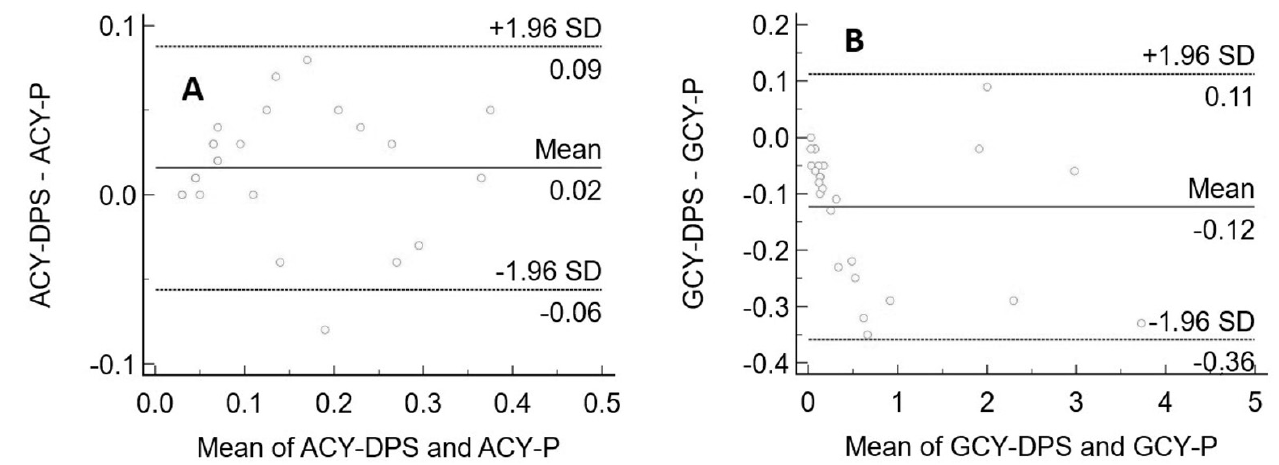
Figure 4. Bland–Altman plots between aciclovir ( A ) and ganciclovir ( B ) concentrations extracted from plasma. On the x -axis are the average of the plasma concentration and DPS concentration of aciclovir/ganciclovir (mg/L) measured from plasma and DPS, and the y -axis represents the difference between the plasma concentrations and DPS concentrations of aciclovir/ganciclovir (mg/L).